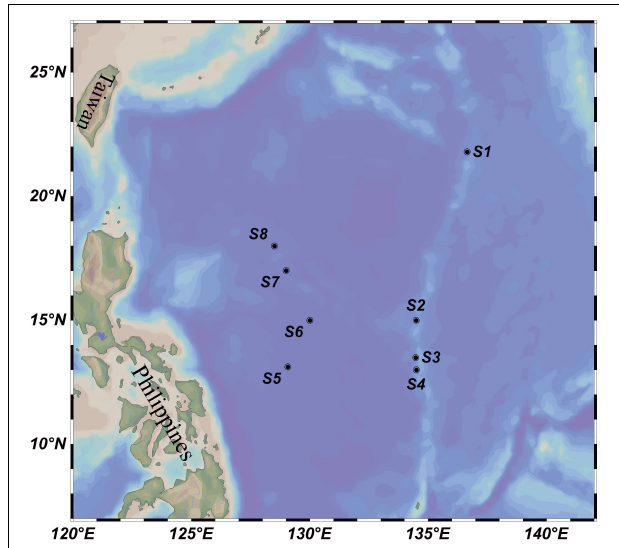
FIGURE 1 | Location of eight water column sampling sites (black circles) in the western subtropical Pacific